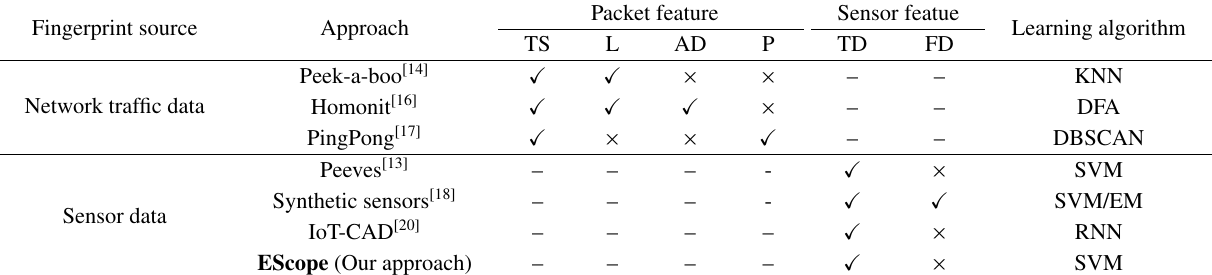
Table 1 Analysis of existing approaches on event